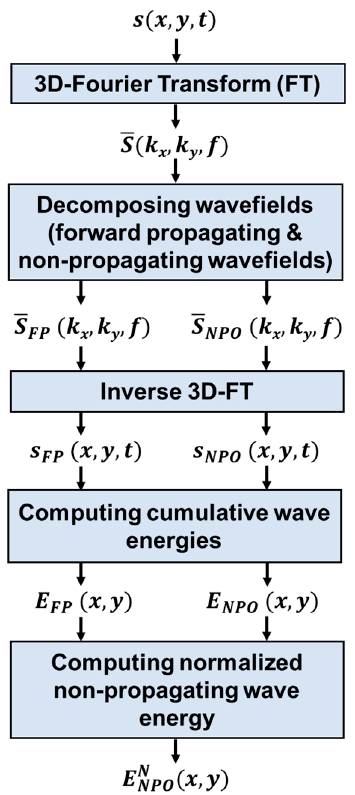
Figure 2. An overview of the proposed f-k domain wavefield data processing approach.